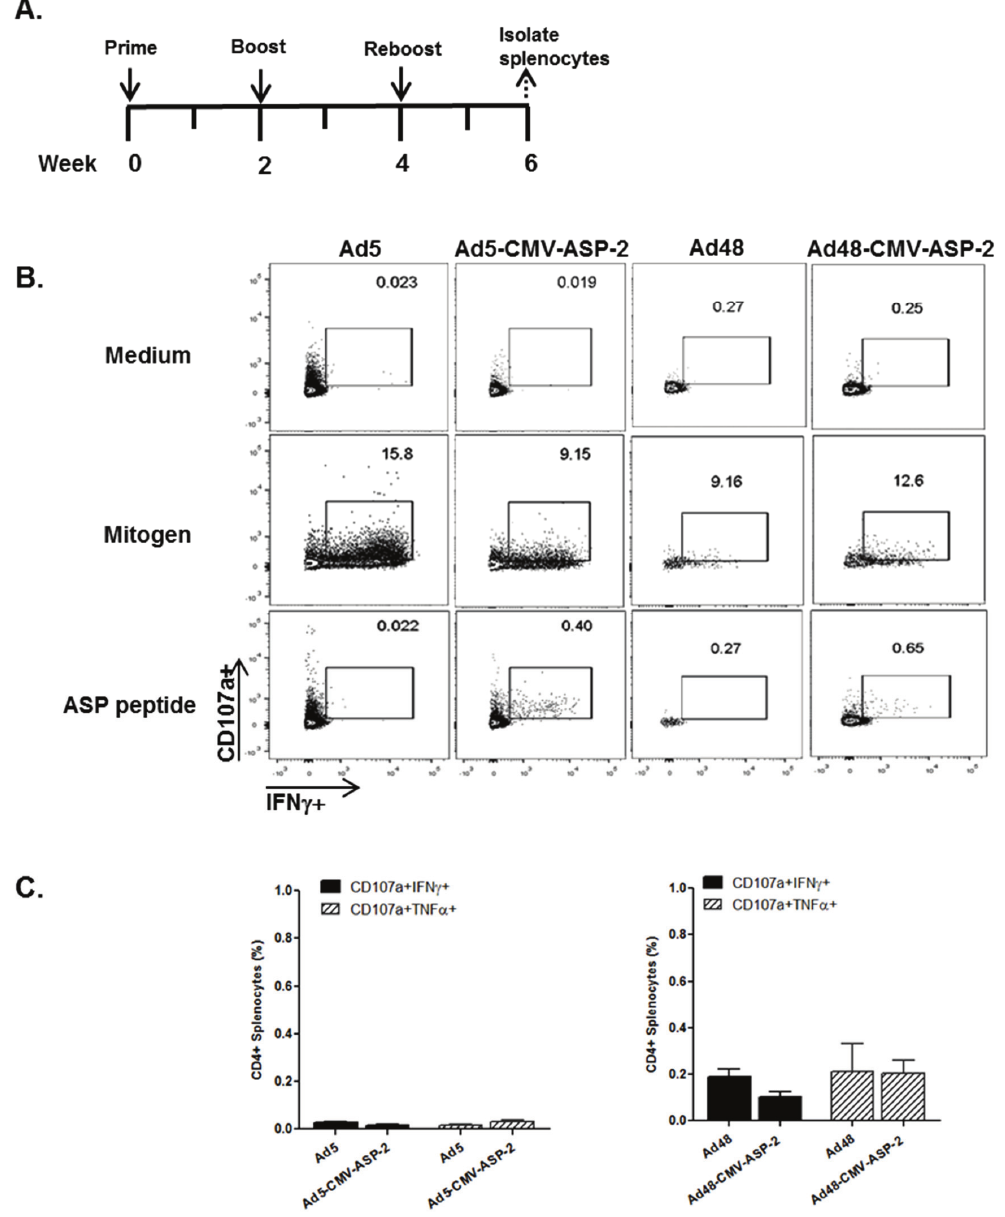
Figure 4. Cont . Figure 4.